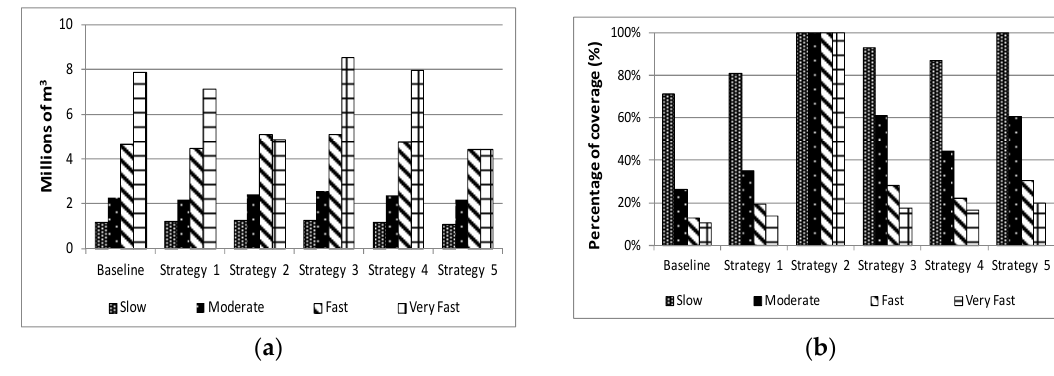
Figure 6. ( a ) Total water demand by 2030 for various growth scenarios and ( b ) Percentage of demand coverage by supply in 2030 for various intervention strategies in Puerto Ayora.